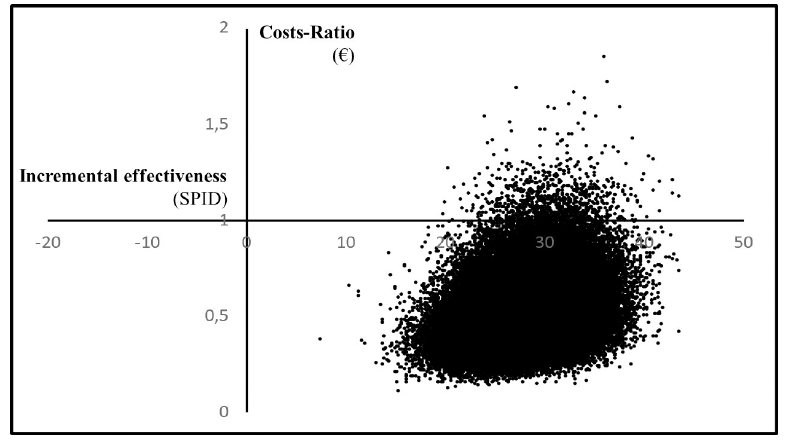
Fig 1. Cost-effectiveness plane.